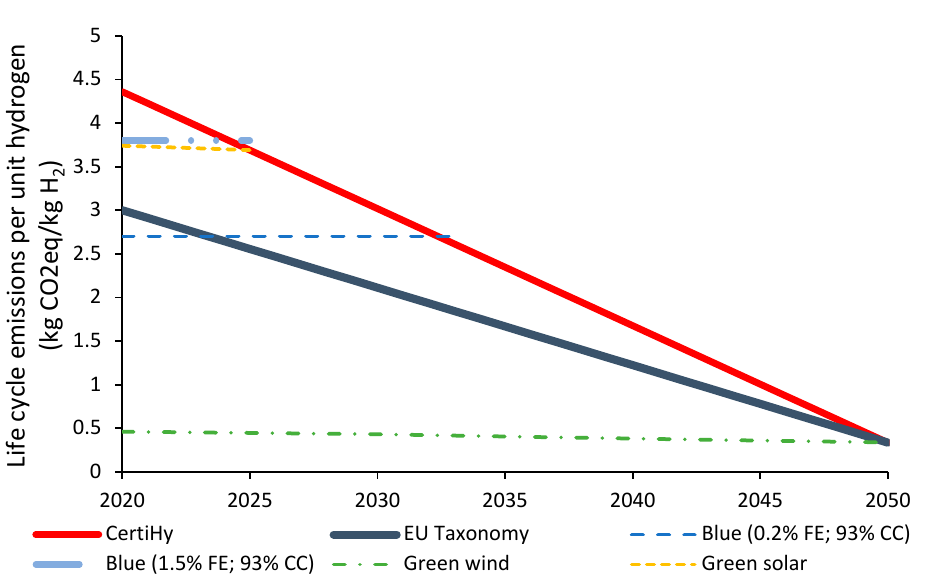
Figure 3. A mapping of an estimation of the “safe” space hydrogen life cycle emissions, with the GO level for net zero friendly hydrogen depicting a linear decrease from the current suggested level for “environmentally safe” hydrogen to the estimated levels depicted in Table 2. The other lines illustrate the life cycle emissions from different means of production for blue and green hydrogen.